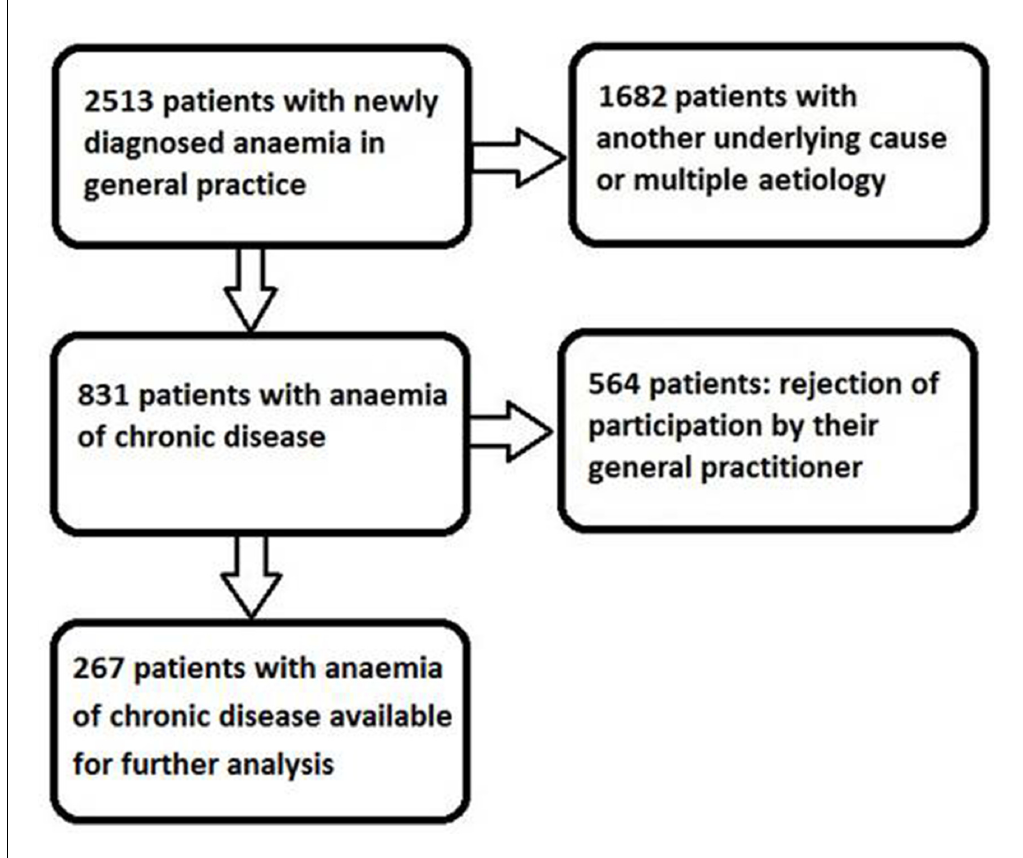
Figure 1. Flow diagram of the selection of study